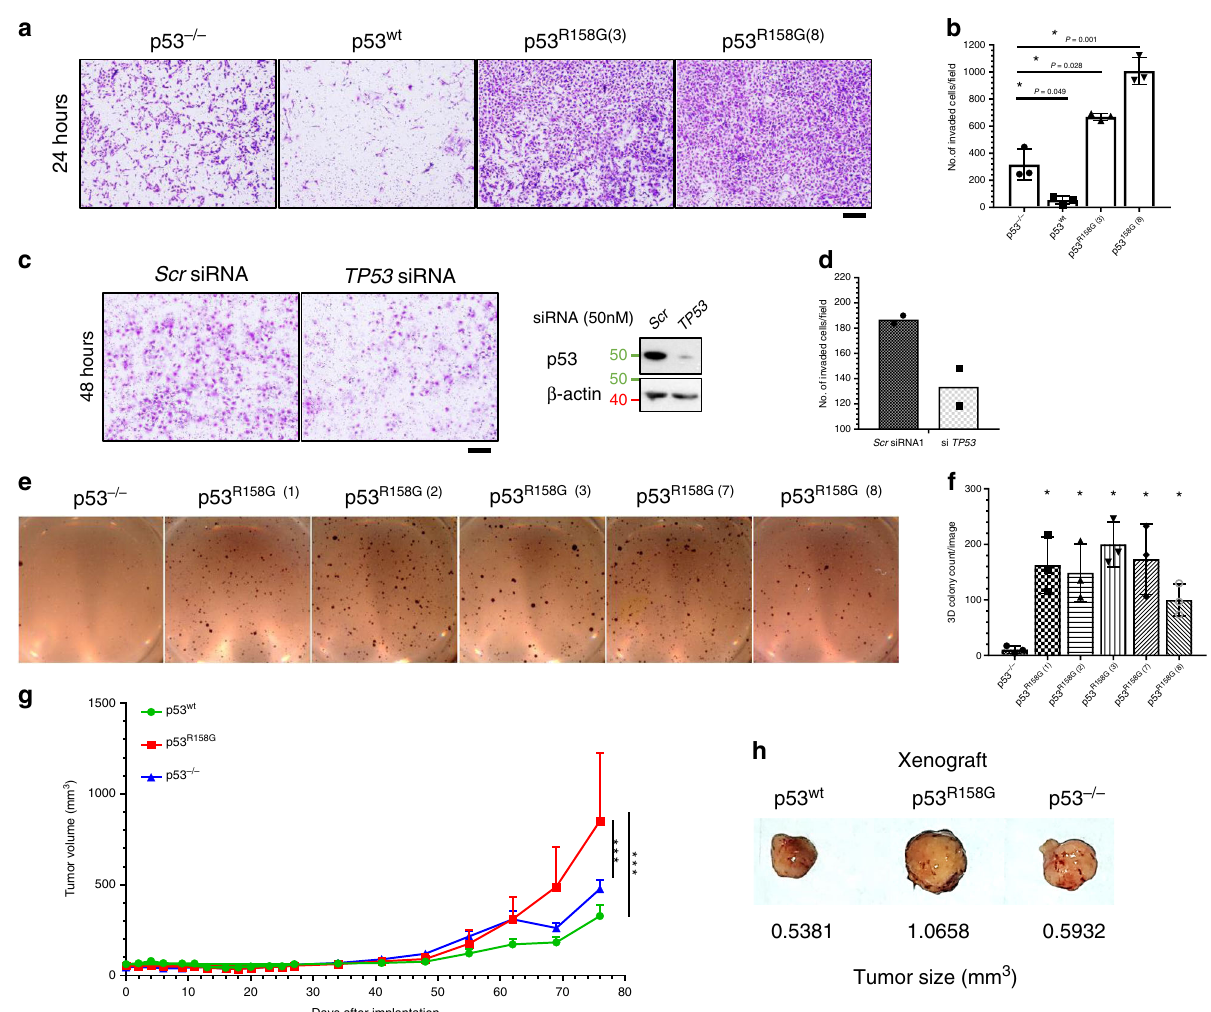
Fig. 1 Mutation at Arg 158 is a GOF p53 isoform. a – d Cell invasion assays were performed on isogenic Calu-1 cells (p53 − / − , p53 wt and mutp53 R158G ) and H2170 cells. Cells seeded in Matrigel invasion chambers were fi xed and stained at the indicated time point. Representative images were shown for Calu-1 clones ( n = 3 independent experiments) ( a ) and H2170 cells with Scr of TP53 siRNA knockdown ( n = 2 independent experiments) ( c ). Immunoblots verifying p53 knockdown are shown on the right. The number of cells in four random microscopic fi elds ×4 were quanti fi ed for Calu-1 ( b ) and H2170 ( d ) cells. Data are expressed as mean ± SD. 50 nM of siRNA used per transfection. Two tailed Student ’ s t -test; * P < 0.05. Scale bar, 200 µ m. e , f Anchorage- independent colony forming assays were performed on isogenic Calu-1 cells (p53 − / − and fi ve independent mutp53 R158G clones). Representative images of colony formation for each cell type, stained with MTT at assay endpoint ( e ). The number of colonies were quanti fi ed ( f ) and expressed as mean of triplicates ± SD ( n = 3 independent experiments). Two tailed Student ’ s t -test; * P < 0.05. g , h In vivo growth rates of p53 − / − , p53 wt , p53 R158G cells were measured upon day of implantation and monitored over time ( g ). Images shown are representative tumor sizes at assay endpoint ( h ). Tumor sizes are presented as mean ± SEM ( n = 5 animals). Two-way ANOVA with Bonferroni correction; * P < 0.05; ** P < 0.01; *** P <